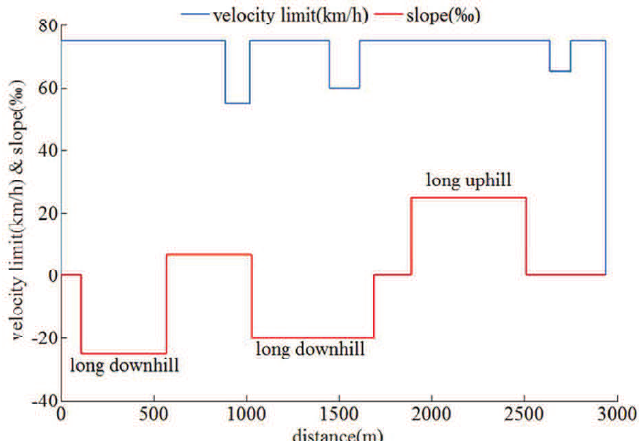
Figure 16. The schematic diagram of ramp parameters and train speed